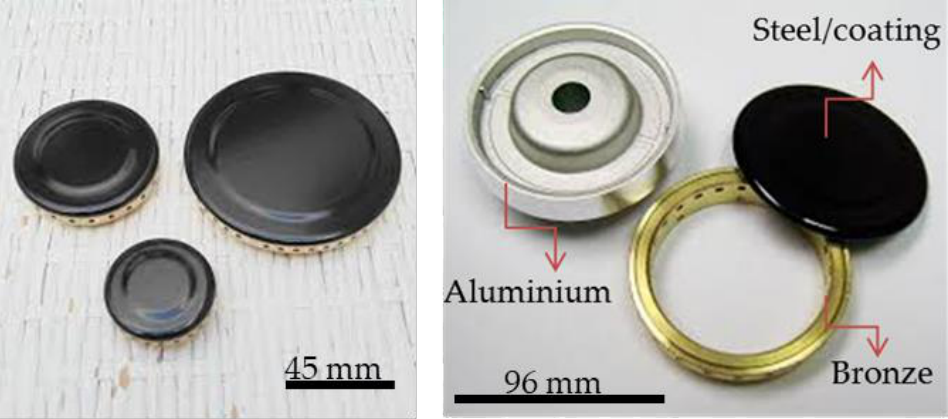
Figure 1. Burner caps from Teka (Spain) [61].